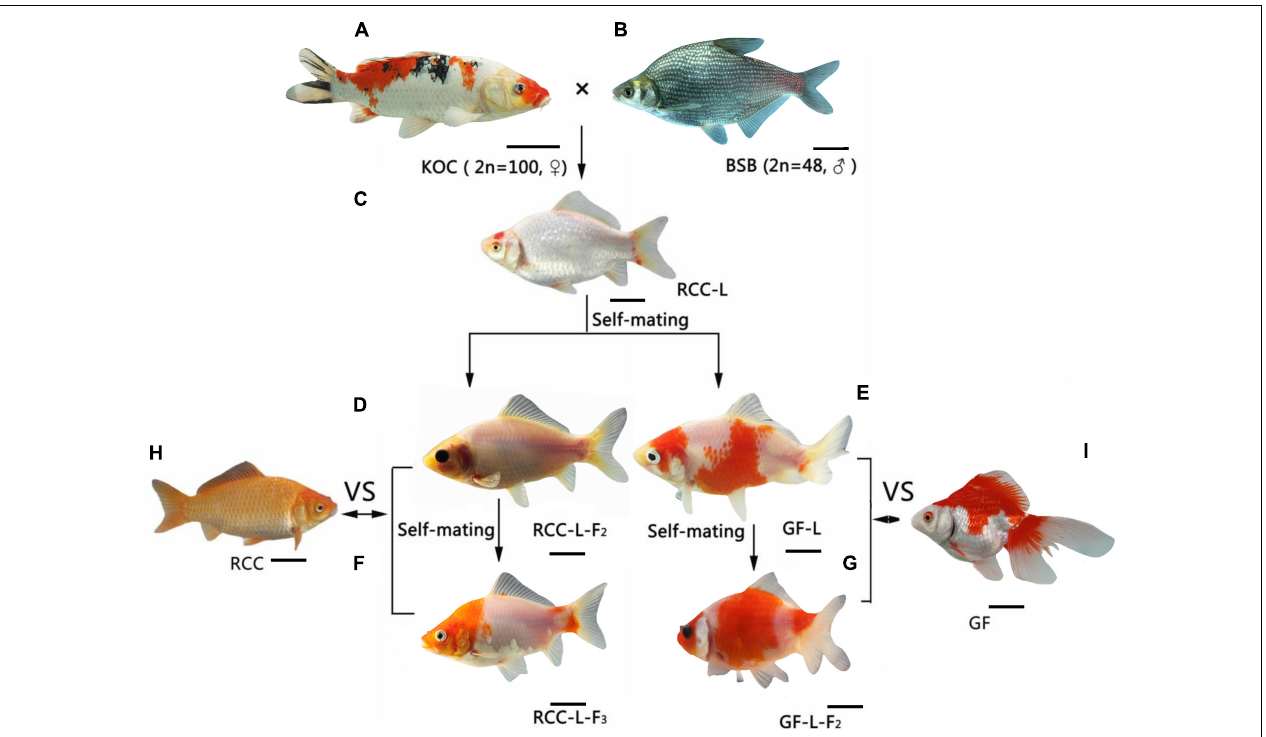
FIGURE 1 | The formation of the hybrid lineages RCC-L (RCC-L-F 1 − 3 ) and GF-L (GF-L-F 1 − 2 ) from the distant cross of female koi carp (KOC) and male blunt snout bream (BSB), (A) KOC, (B) BSB, (C) RCC-L, (D) RCC-L-F 2 , (E) GF-L, (F) RCC-L-F 3 , (G) GF-L-F 2 , (H) RCC, (I) GF, Bar = 3